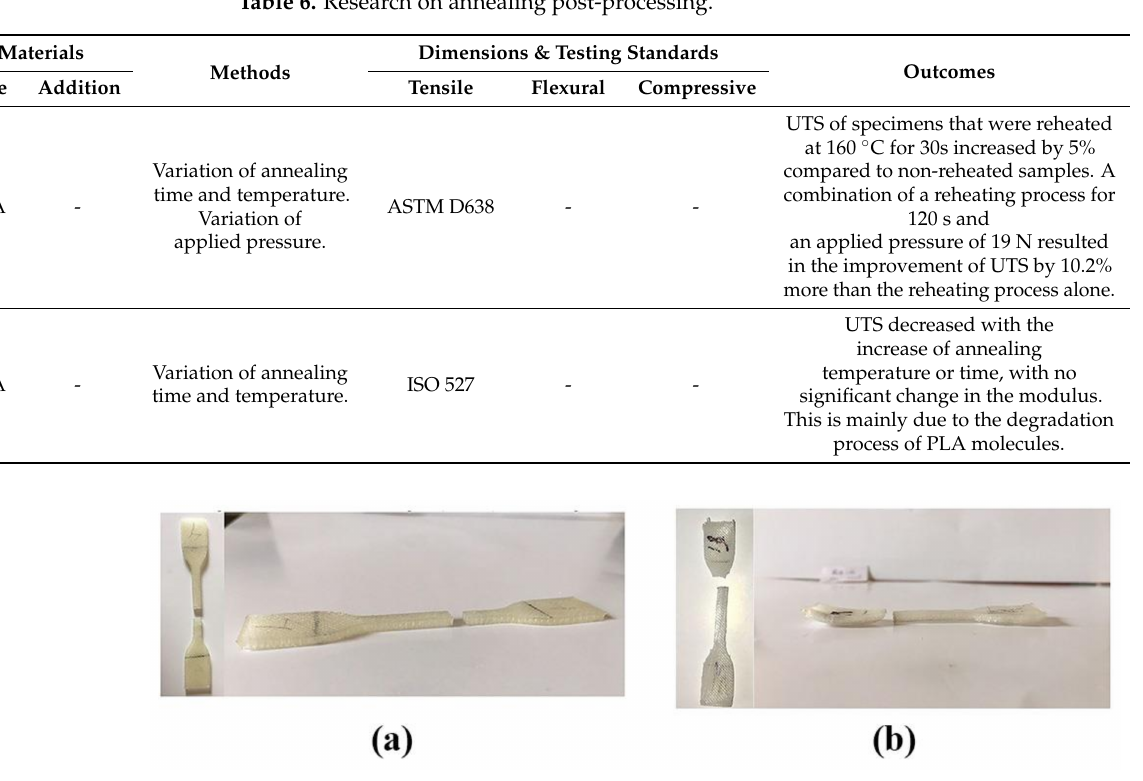
Figure 14. The tensile specimen ( a ) before, and ( b ) after the annealing process. Reprinted with permission from [82]. Copyright 2020, Emerald Publishing